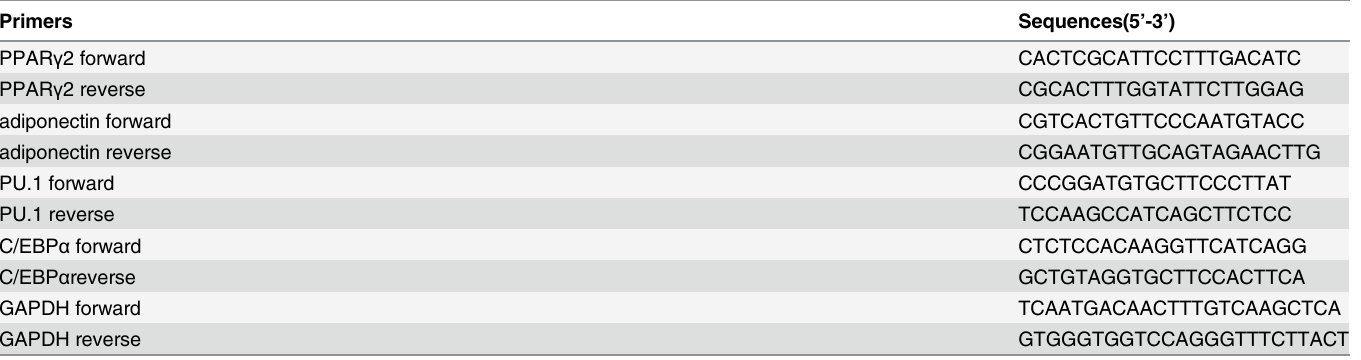
Table 1. Sequences of the primers used for